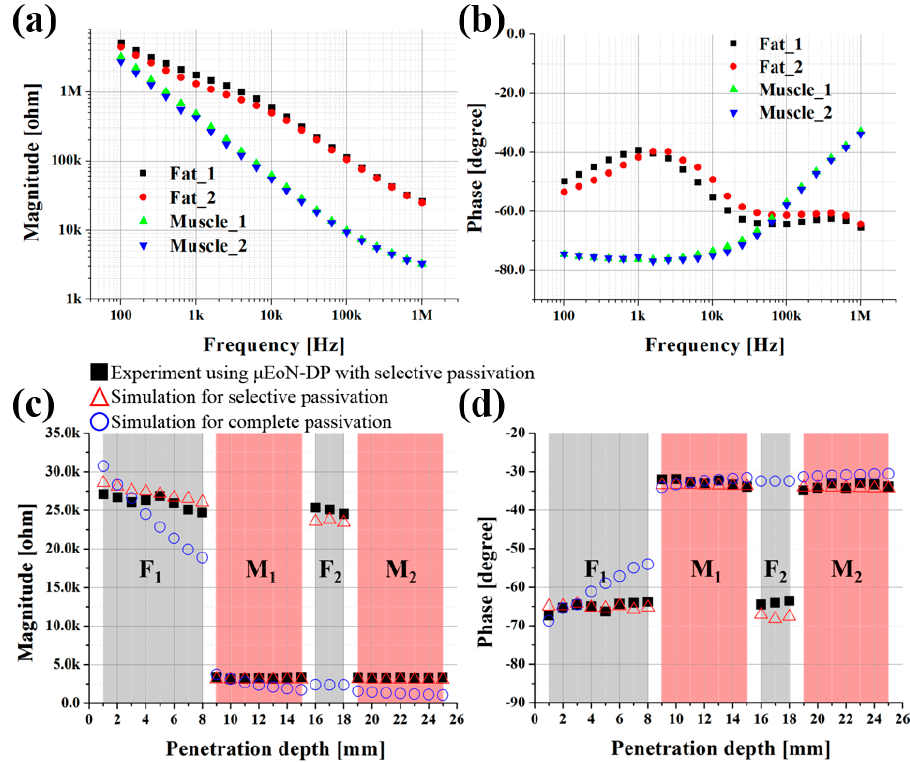
Figure 5. Mean impedance of each layer in four-layered porcine tissue: ( a ) magnitude and ( b ) phase; depth profiling and simulation results obtained at the optimal frequency for four-layered porcine tissue: ( c ) magnitude and ( d ) phase (simulations were carried out to verify the advantage of selective passivation over complete passivation in terms of sensor output).